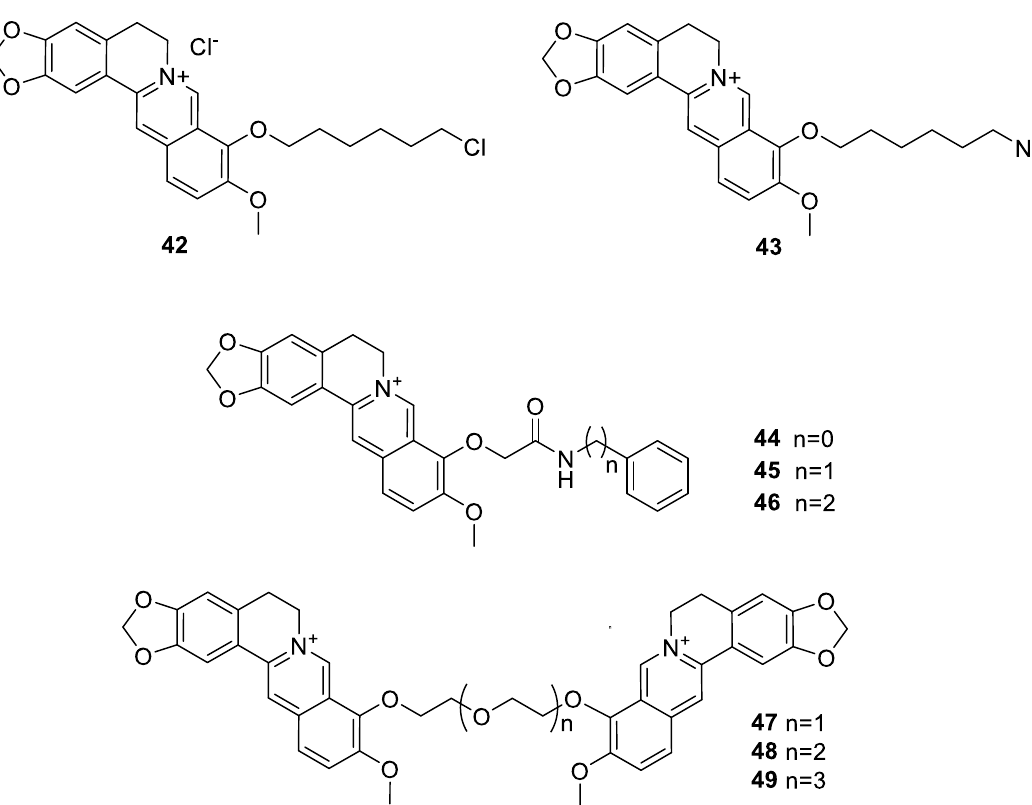
Figure 5. Further berberine- 9- O -derivatives [135 – 137].